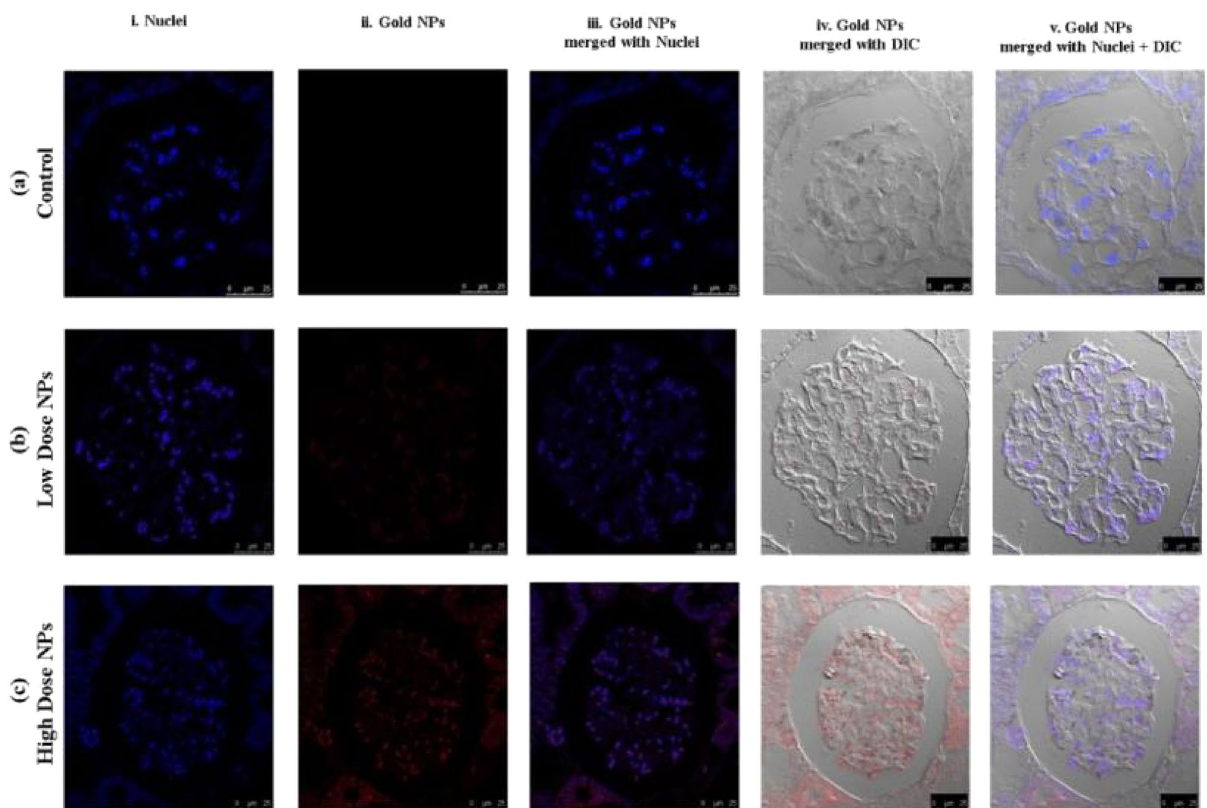
Figure 7. In vivo biodistribution and localization of Au-NPs at different doses (High & Low) in rat kidney tissues. Confocal fluorescence images of rat kidney tissues ( A ) Control group, ( B ) Rat group treated with high dose Au-NPs, and ( C ) Rat group treated with low dose Au-NPs . (i) Blue: Hoechst 33342-stained nuclei. (ii) Red: Gold NPs. (iii) Merged Image from Gold NPs and Nuclei. (iv) DIC mode merged with Gold NPs (v) DIC mode merged with Gold NPs and nuclei. λ max = 505 nm (Hoechst 33342), 555 nm (red autofluorescence from gold NPs), 473 nm (Differential interference contrast [DIC]). (Confocal Laser Scanning Microscope × 63, Scale bar: 25 μm, Scan Mode = XYZ Unidirectional X, Scan Speed = 400 Hz, Pinhole Diameter = 137.1